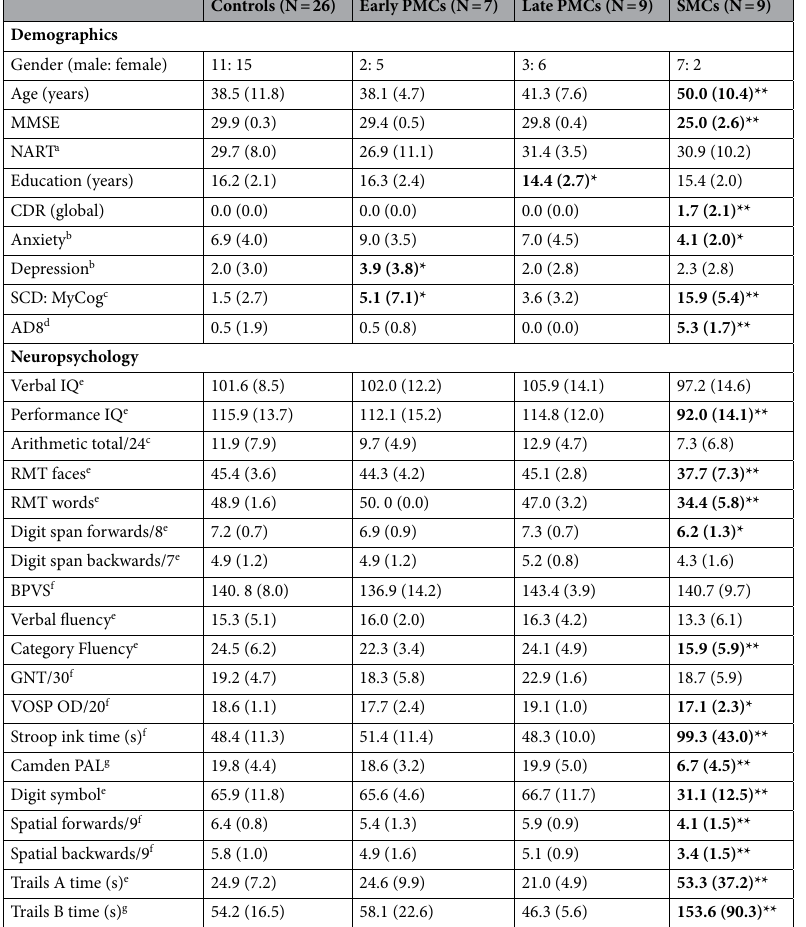
Table 1. Participant demographics and neuropsychology: mean and SD unless stated otherwise. SD standard deviation, PMC presymptomatic mutation carrier, SMC symptomatic mutation carrier, MMSE mini-mental state examination, CDR clinical dementia rating scale; Anxiety and depression from the HADS hospital anxiety and depression scale, SCD subjective cognitive decline, IQ intelligent quotient, RMT recognition memory test, BPVS British Picture Vocabulary Scale, GNT graded naming test, VOSP OD Visual Object and Space Perception Battery: Object Decision, NART National Adult Reading Test, Camden PAL Camden paired associated learning; Digit spans forwards and backwards from the WMS-R = Wechsler Memory Scale. a n = 48; b n = 38; c n = 39; d n = 37; e n = 44; f n = 43; g n = 42. Bold = significant; *significant at p < 0.05; **significant at p <